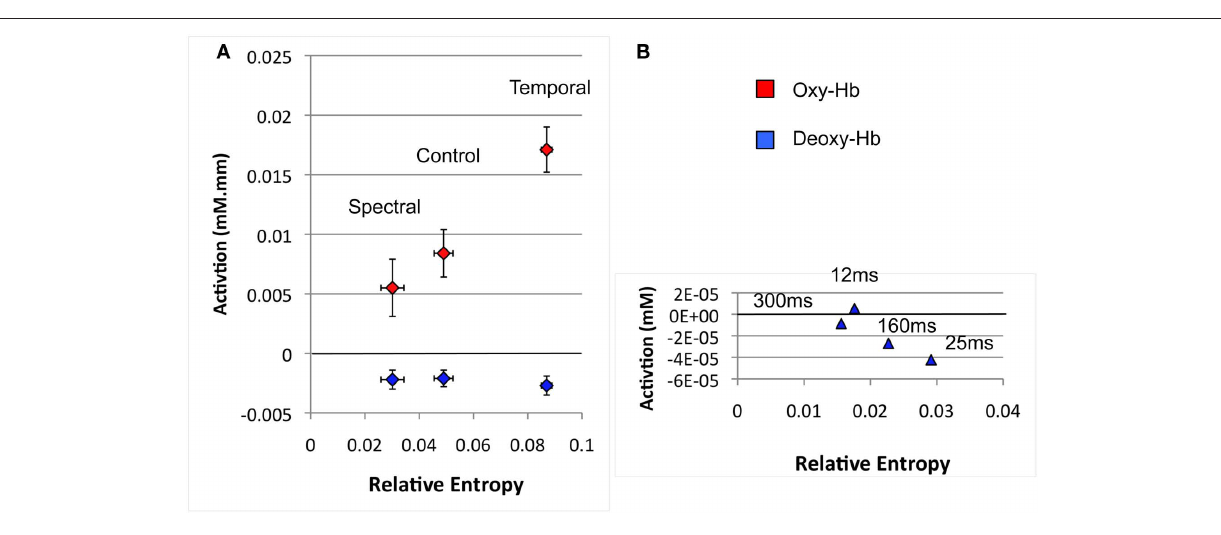
have been calculated over the three reported temporal channels in both hemispheres. Relative Entropy was computed as ∑ − ⋅ + + i ti ti ti ti p p p p ( ) log( / ), ∆ ∆ where p ti is the proportion of spectral energy in band i at time t , and ∆ = 25 ms.